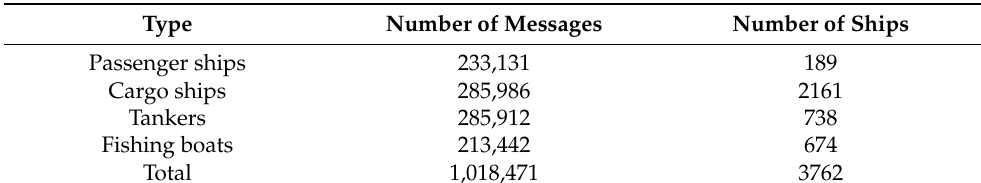
Table 4. The number of original dynamic data.